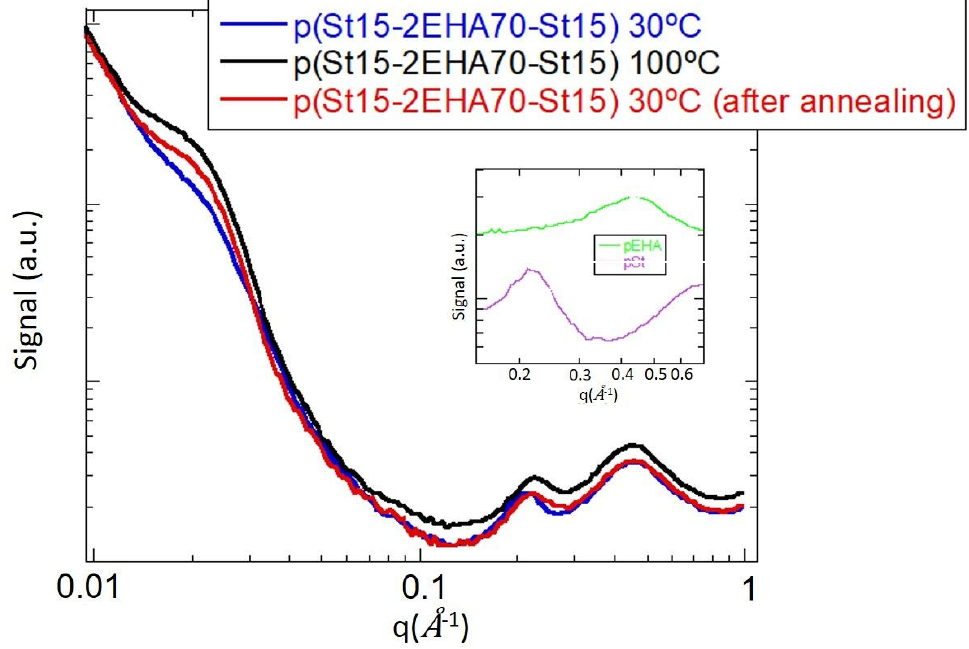
100 and 30 ◦ C after the analysis at 100 ◦ C. Inserted: SAXS of pSt and pEHA homopolymers obtained by Figure 9. SAXS of the sample p(St15-2EHA70-St15) dried at room temperature and measured at 30, RAFT 100 and 30 °C after the analysis at 100 °C. Inserted: SAXS of pSt and pEHA homopolymers obtained by RAFT polymerization.